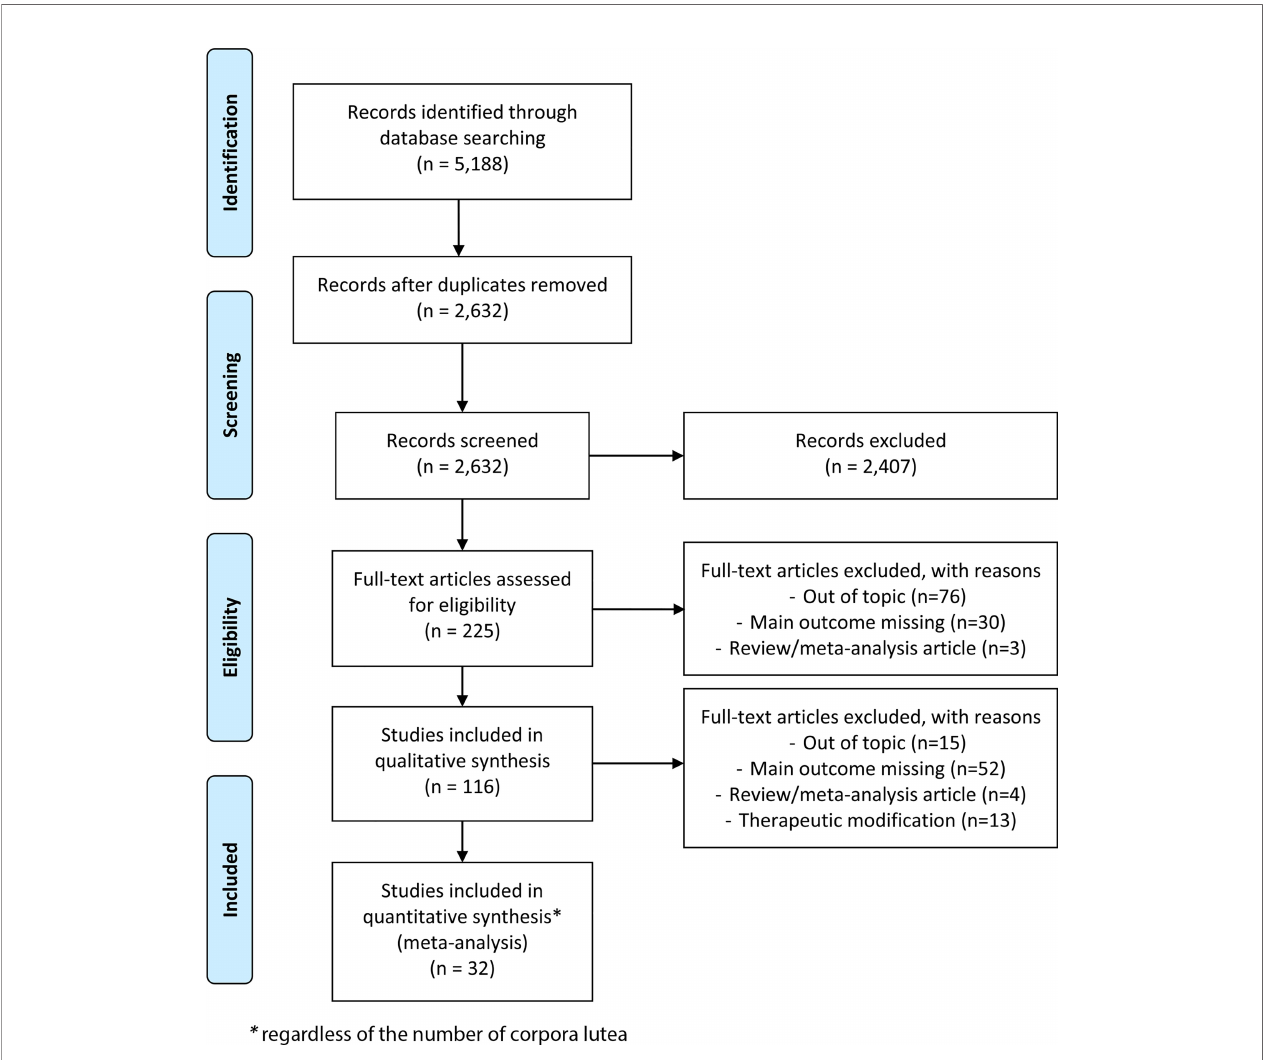
FIGURE 2 | Study fl